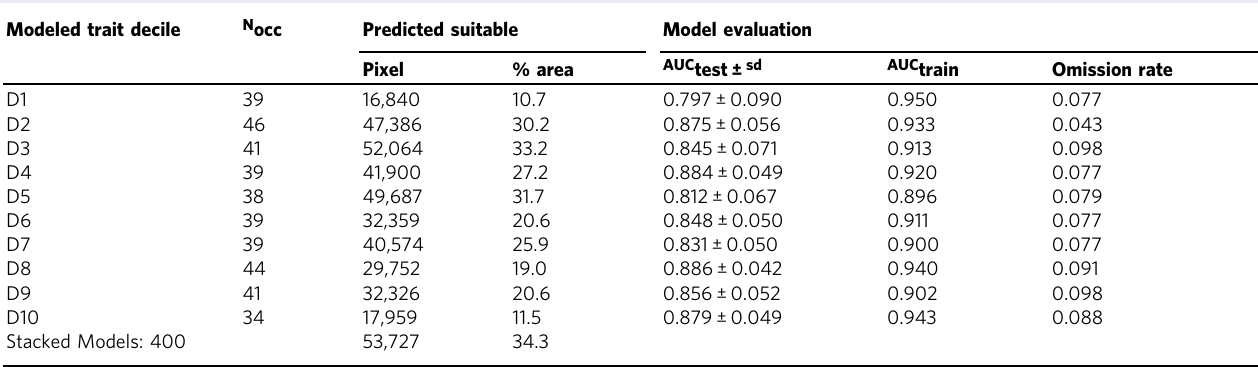
Predicted suitableclimaticconditions onthe landscapeare listedboth aspixel numberand aspercent areaof the total extentof the landscape(total pixels = 156,659).Each pixel has anareaof ~1km 2 , a resolutionof30arcseconds.TestAUC(areaunderthereceivingoperatingcharacteristiccurve) + / − standarddeviationsaregivenfrom5-foldcross-validation.TrainingAUCisfor fi nalmodels.Training omission rate is for the 10-percentile training presence threshold